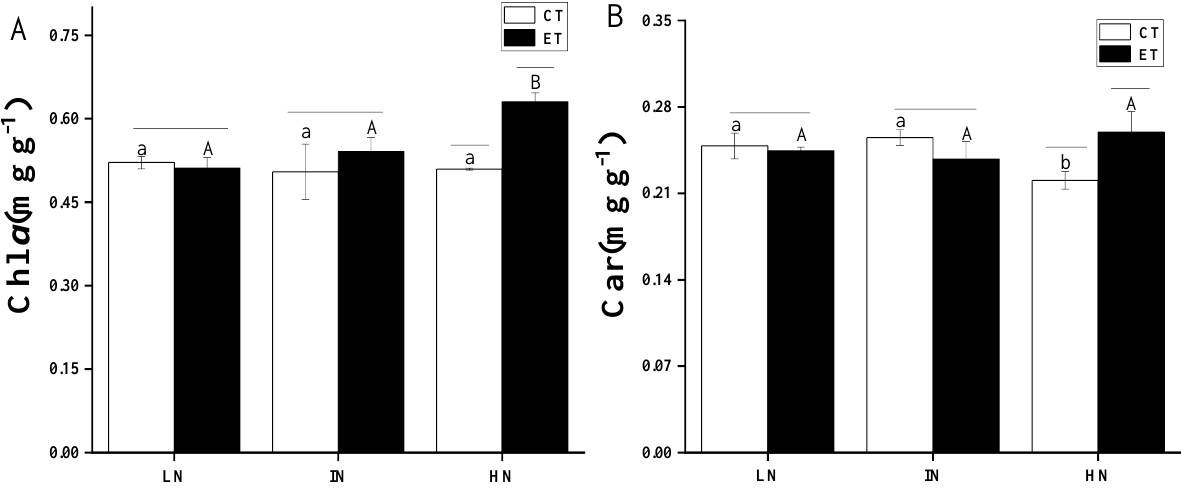
Figure 5. Contents of Chlorophyll-a (Chl a ) ( A ) and carotenoids (Car) ( B ) of S. horneri under LN, IN, and HN treated by CT and ET. Data are means ± SD (n = 3). Horizontal lines represent the significant difference ( p < 0.05) among the temperature levels at the same N concentration, the different capital letters represent significant differences ( p < 0.05) among N concentrations at the elevated temperature, while the different lower-case letters represent significant differences ( p < 0.05) among N concentrations at the ambient temperature.